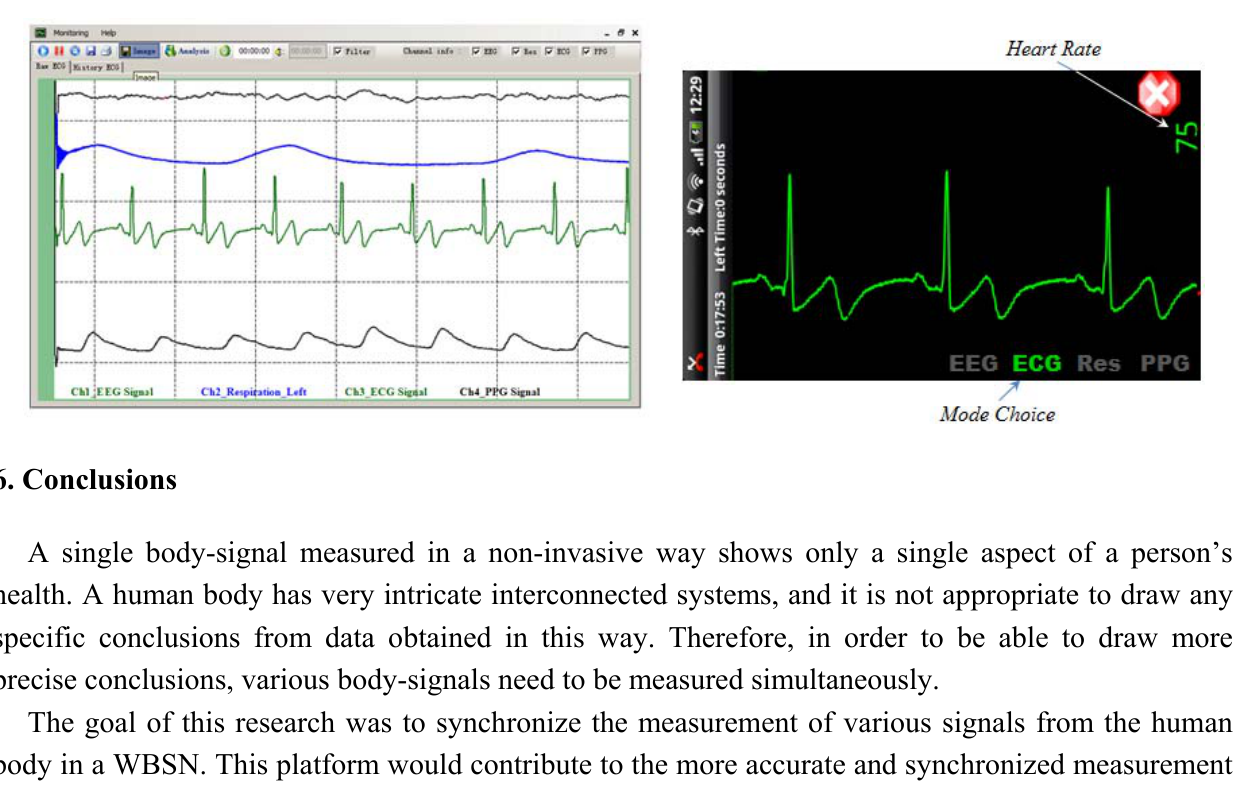
Figure 12. Screenshot of the integrated healthcare monitoring system ( on the left ) and of Smartphone application ( on the right